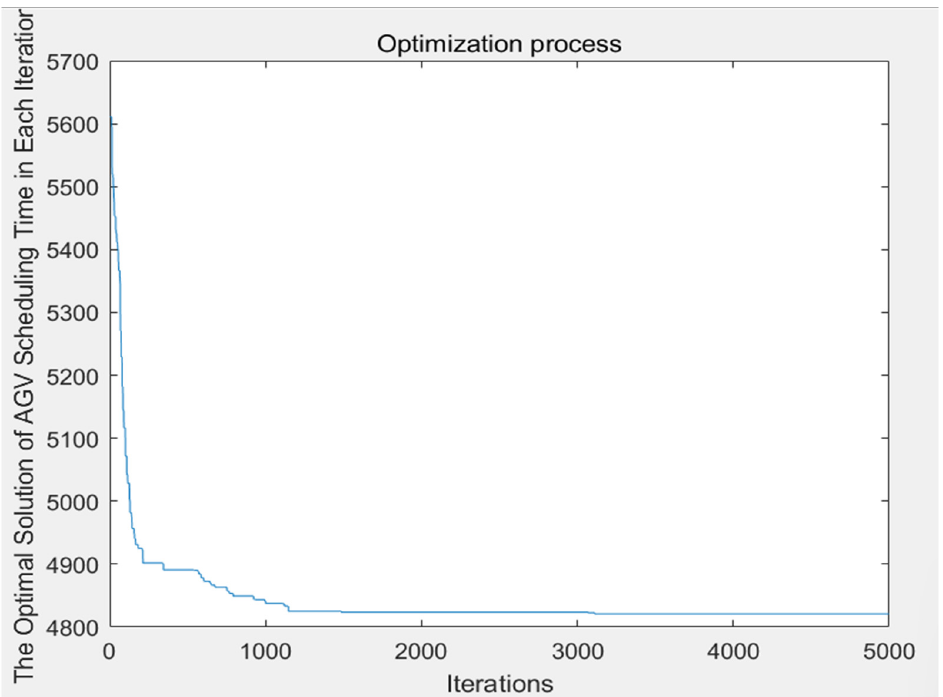
Figure 8. Convergence Diagram of Genetic Algorithm.